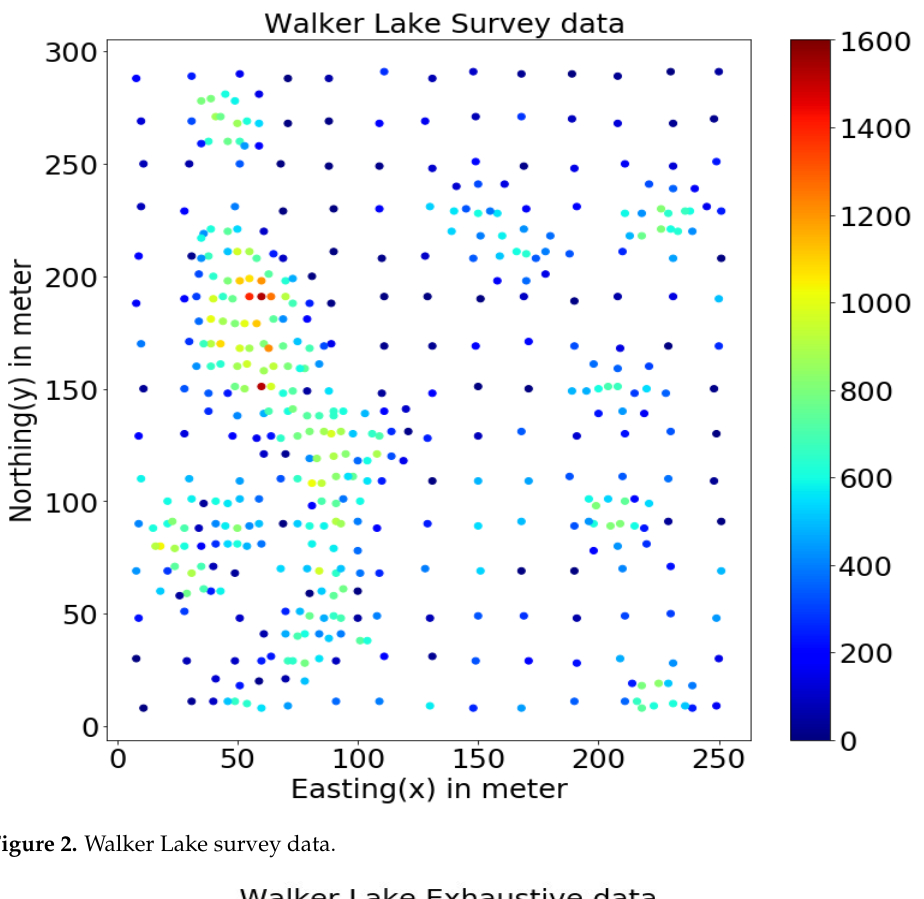
Figure 2. Walker Lake survey data.